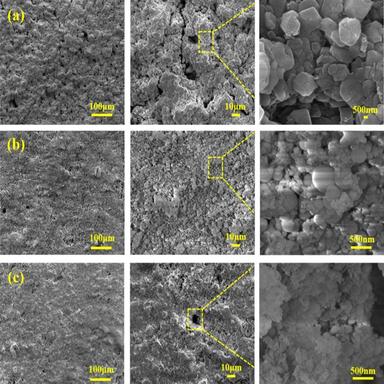
SEM images of (a) ordinary concrete surface, (b) superhydrophobic concrete surface and (c) the pore of superhydrophobic concrete.